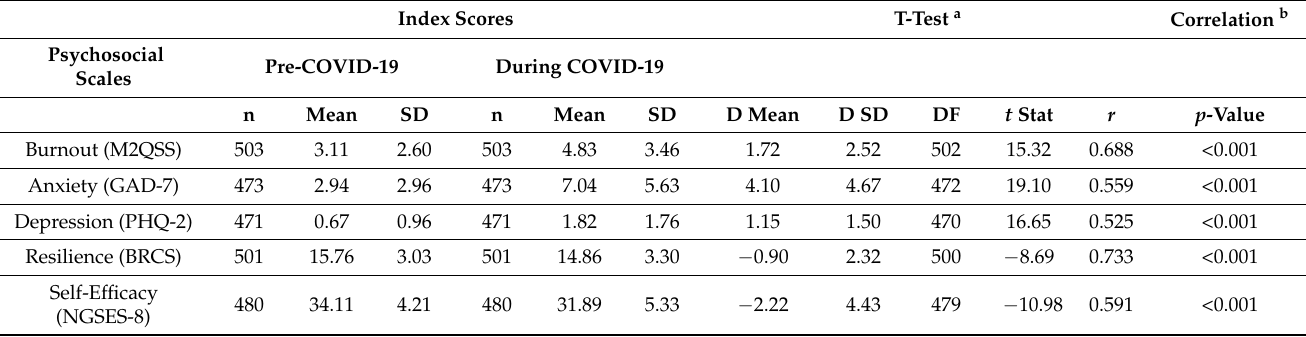
Table 4. Changes in self-reported psychosocial conditions, pre-COVID-19 and during COVID-19. Index Scores T-Test a Correlation b